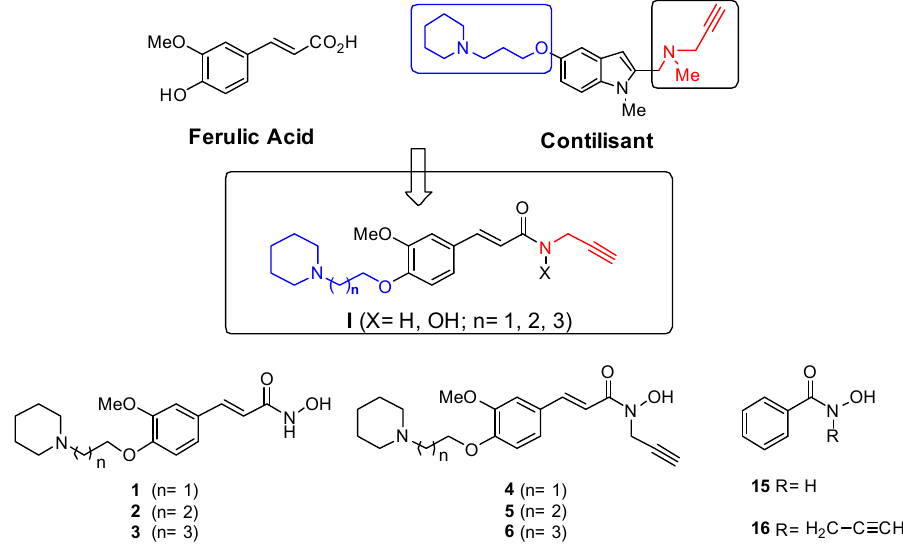
Figure 1. Structures of ferulic acid, Contilisant , the novel N -hydroxy[ N -(prop-2-yn-1-yl)]amides 1–6 derived from ferulic acid, and ligands 15 and 16 described in this work.